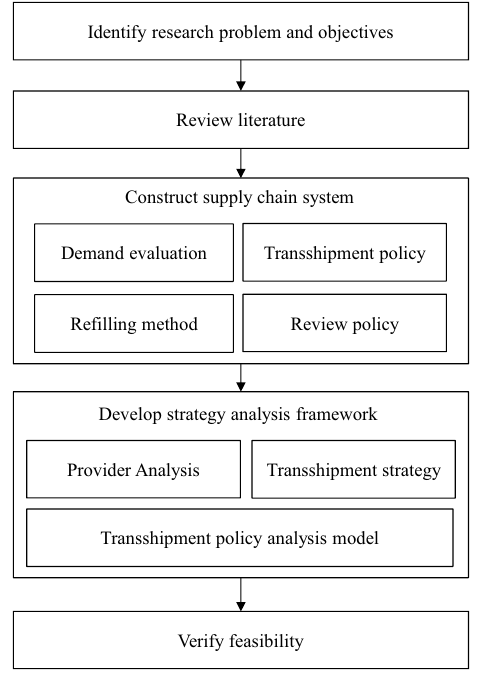
Fig. 1. Research flow